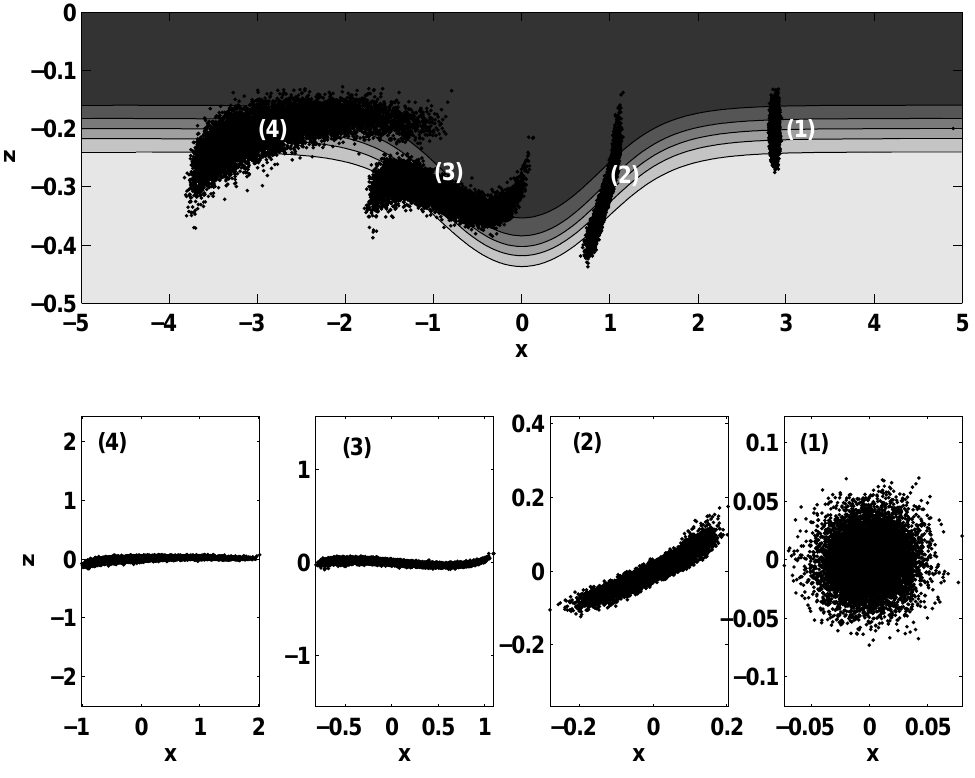
Fig. 1. The motion of a 10000 member ensemble of particles initially located upstream of the ISW and at the center of the pycnocline superimposed on a shaded plot of density contours. Subsequent times evolve from right to left and are separated by 16 . 4 time units. In the upper panel the entire horizontal extent of the ISW is shown, however only a portion of the computational domain is shown. Since ISWs are long waves, panels (1)–(4) show a 1:1 aspect ratio of the particle clouds with the same labels as in the upper panel. Note the increase in scale as time